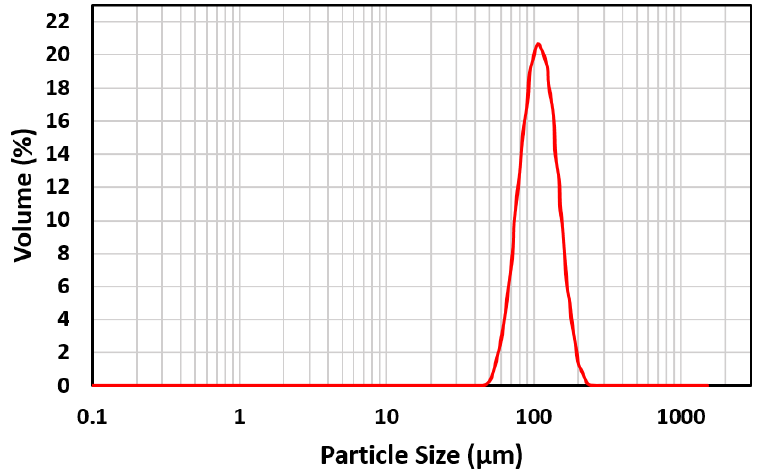
Figure 1. Powder particle size distribution measured by laser diffraction technique.